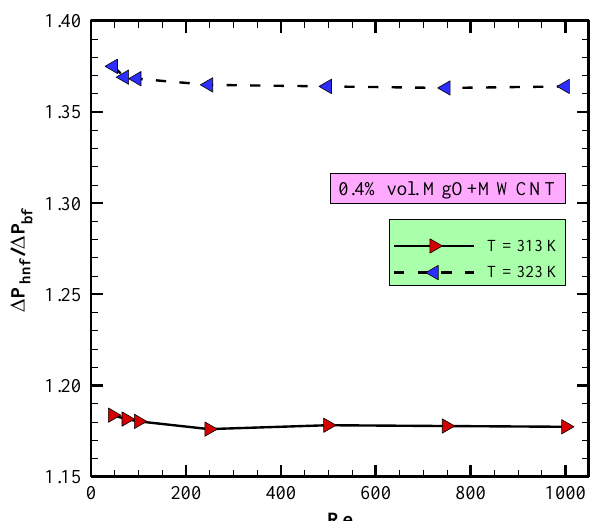
Figure 12. Effects of HNF with volume fraction of 0.4% on PD ratio for different Re and inlet temperature T = 313 K and 323 K.